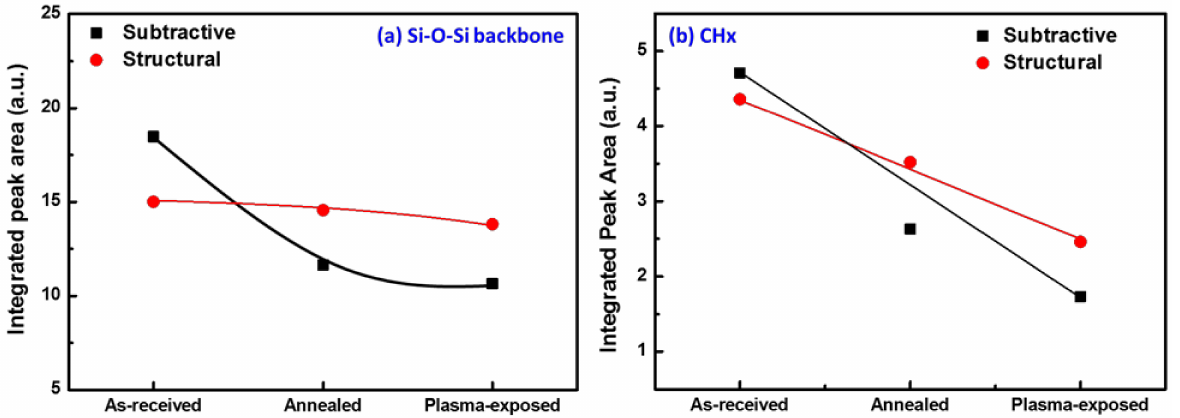
Figure 6. Peak area variations of ( a ) Si-O-Si, and ( b ) CHx after anneal and plasma exposure.